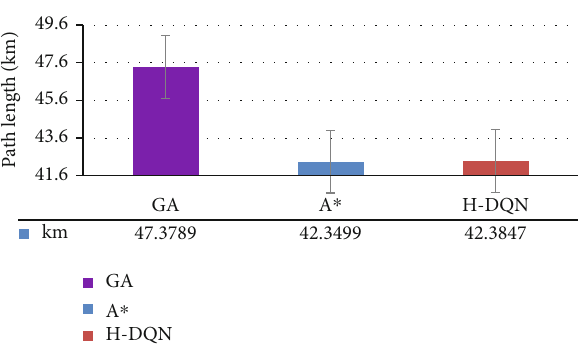
Figure 10: Path planning test for GA and A ∗ algorithm.